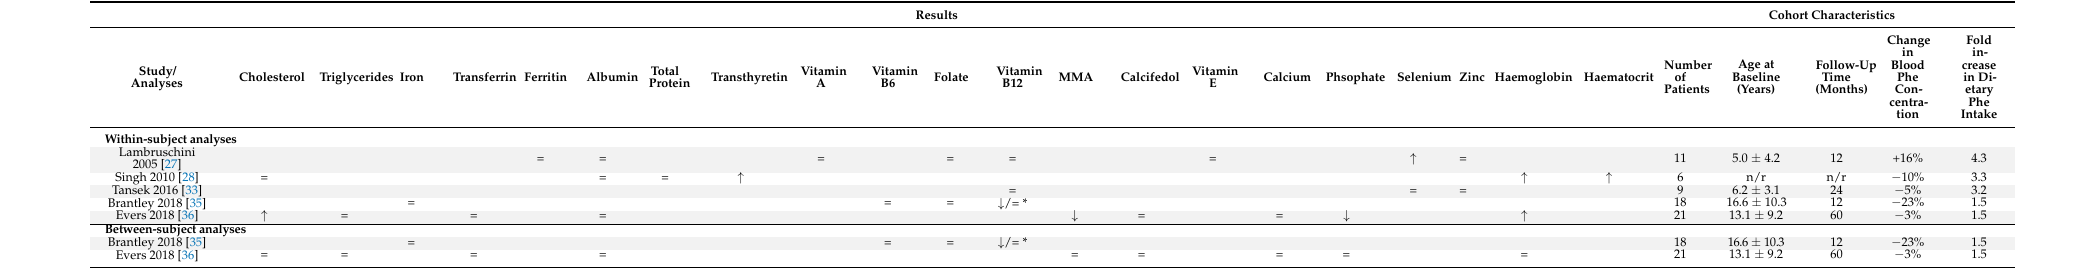
Table 4. Results of within-subject (baseline versus last point of follow-up during BH 4 treatment) and between-subject (BH 4 -treated group versus control group at last point of follow-up) analyses for different parameters regarding anthropometric measurements. Cohort characteristics are taken from Table 2. =, no significant change (within-subject analyses) of no significant difference (between-subject analyses); ↑ , significant increase or significantly higher in BH 4 -treated group; ↓ , significant decrease or significantly lower in BH 4 -treated group. * No significant difference for patients > 18 years, but a significant difference for patients < 18 years. N/r, not